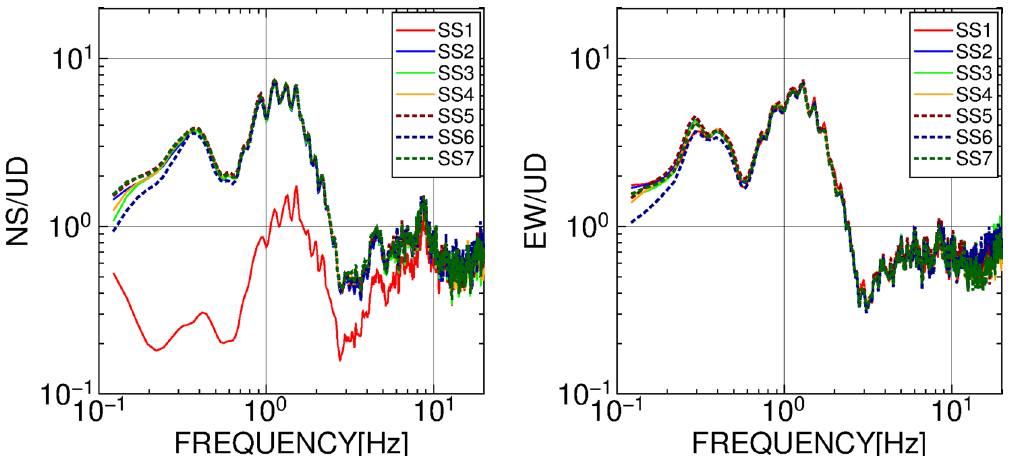
Fig. 1 Observed MHVR (NS/UD and EW/UD) of the array SS near the target site KUMA. We used the root-mean-square (RMS) values of SS2 for the analysis